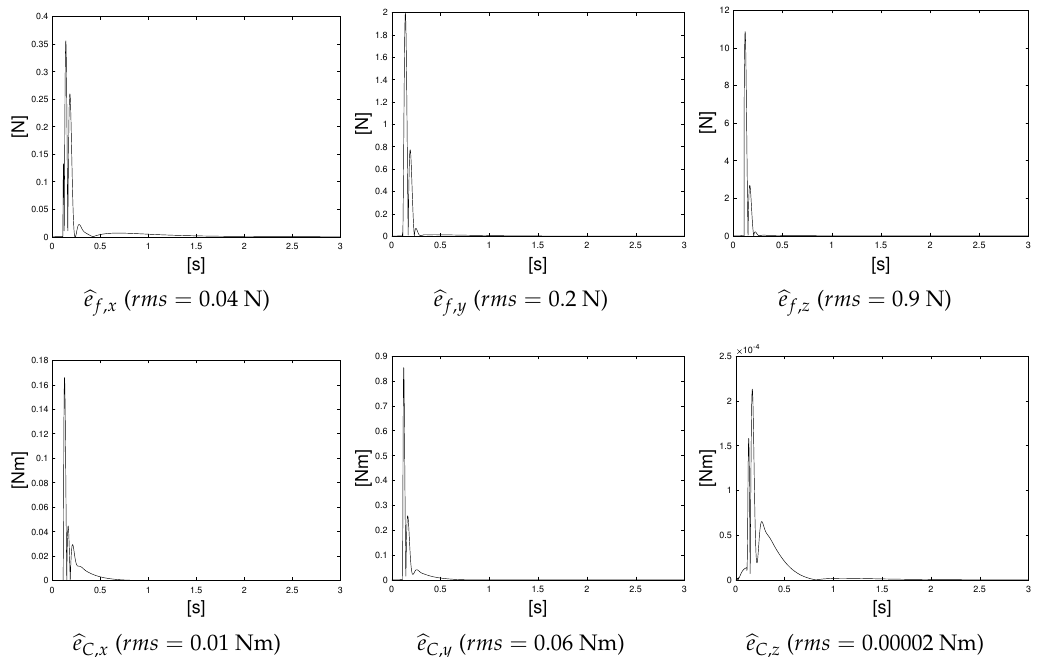
Figure 7. Estimated interaction forces (cid:98) f and torques (cid:98) C (continuous line) vs. real interaction forces f and torques C (dashed line) for the #4 simulation scenario.